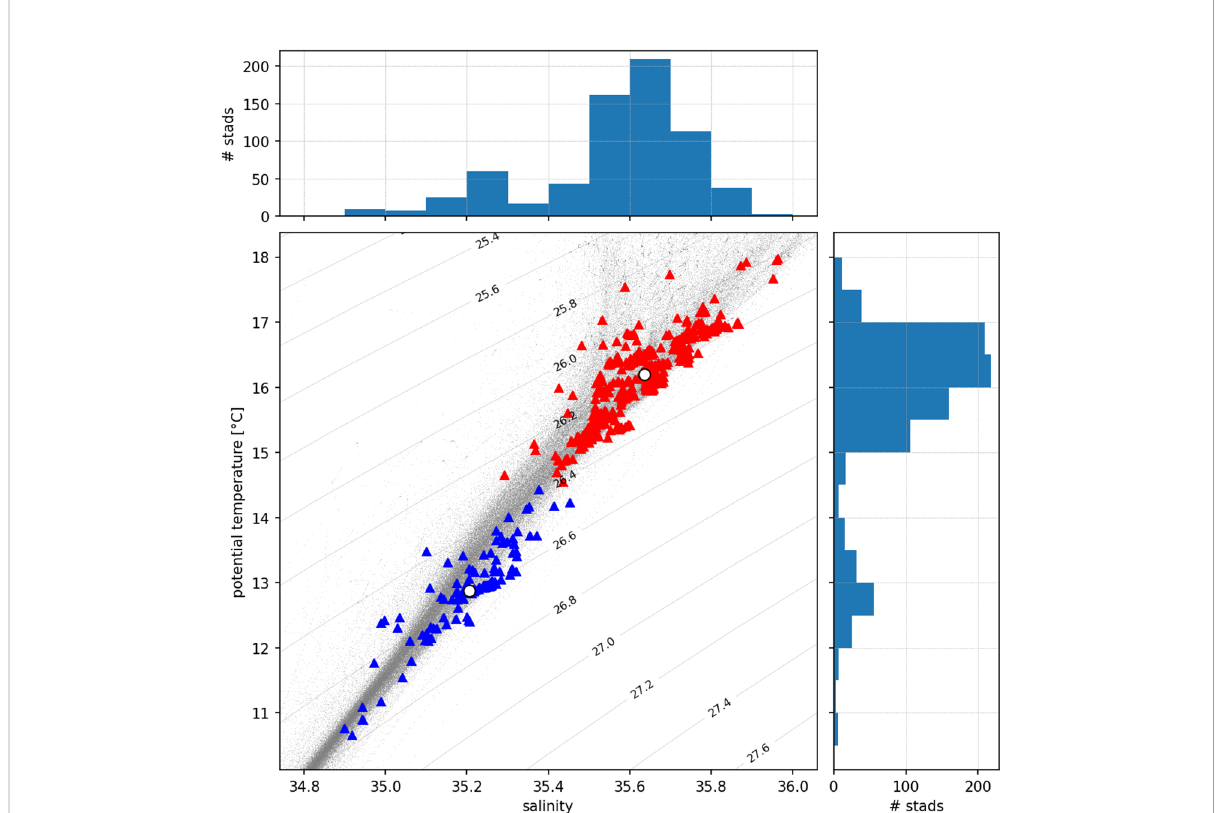
FIGURE 4 Temperature-salinity diagram including all quali fi ed pro fi les acquired inside the rings (gray dots), and histograms of mean salinity (top) and mean temperature (right) of the pycnostads identi fi ed. The triangles show the t-s pairs of the pycnostads, and the white circles show the centroids of each mode water cluster (Type I in red and Type II in blue). The centroids have the following characteristics: Type I (16.2 ± 0.6°C, 35.6 ± 0.1 psu, 26.2 ± 0.1 s q ) and Type II (12.9 ± 0.7°C, 35.2 ± 0.1 psu, 26.6 ± 0.1 s q ).